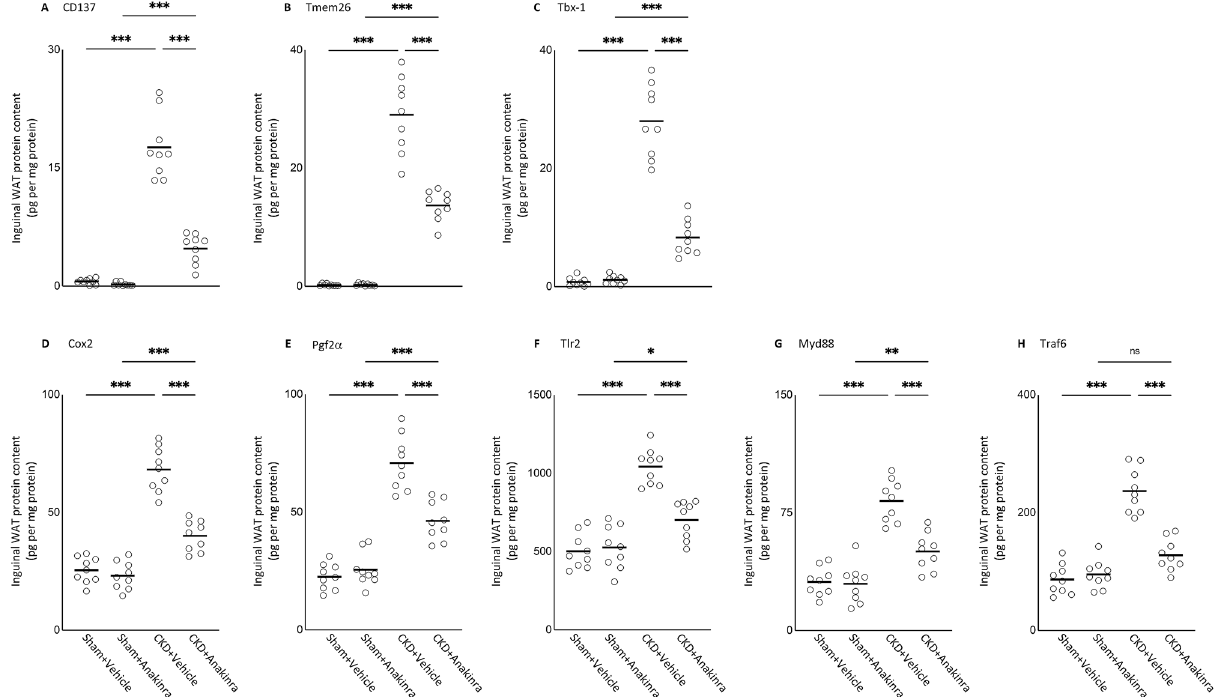
Figure 5. Anakinra attenuates adipose tissue browning in CKD mice. Protein content of beige adipocyte markers (CD137, Tmem26 and Tbx-1) in inguinal white adipose tissue was measured ( A – C ). In addition, protein content of Cox2 signaling pathway (Cox2 and Pgf2α) and toll like receptor pathway (Tlr2, MyD88 and Traf6) in inguinal white adipose tissue was measured ( D – H ). Results of WT/CKD + Vehicle were compared to WT/Sham + Vehicle and WT/CKD + Anakinra were compared to WT/Sham + Anakinra, respectively. In addition, results of WT/CKD + Anakinra were also compared to WT/CKD + Vehicle. * p < 0.05, ** p < 0.01, *** p <